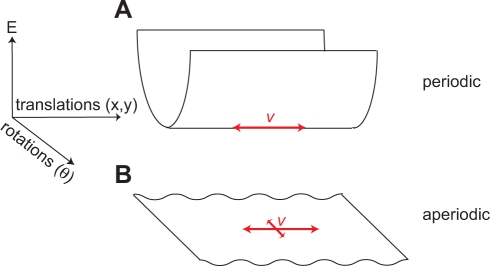
The continuous attractor manifold.(A) Periodic network manifold: Points within the trough represent stable
states of the network that will persist in the absence of perturbing
inputs. If the network is placed at a state outside the trough, it will
rapidly decay to a state within the trough. Points in the trough consist
of continuous translations of the population-level pattern. Rotations,
stretches, or other local or global deformations of the pattern lie
outside the trough. Rat velocity inputs drive transitions between points
in the trough (red arrow). (B) Aperiodic network manifold: all rotations
of a stable population pattern are energetically equivalent, and so form
a continuous attractor manifold. Translations are not equivalent
(rippled energy functional). Rat velocity inputs, when large enough to
overcome the ripple, drive translations of the population pattern;
however, the flat rotational mode means that the network can also
rotate.